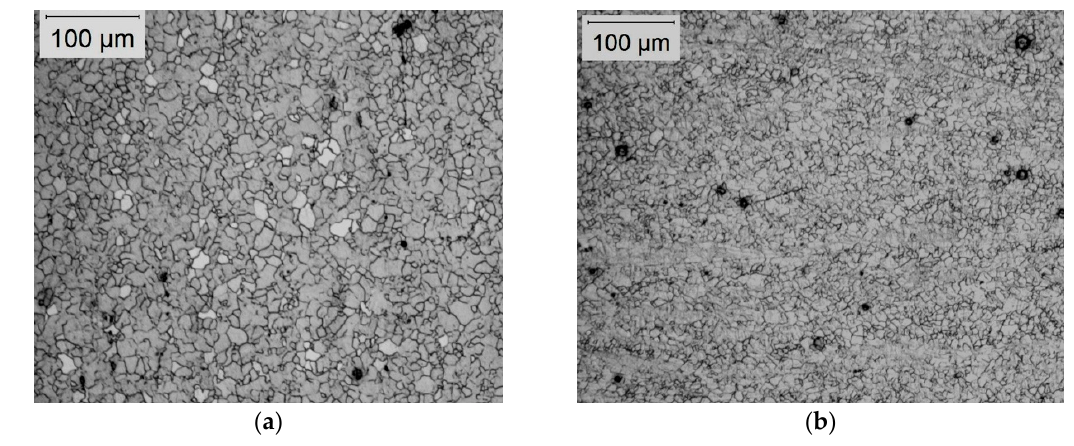
Figure 14. Isotropic microstructures of AZ31 after two sc-ECAE passes + rolling with reductions of 50% ( a ) and 87.5% ( b ).